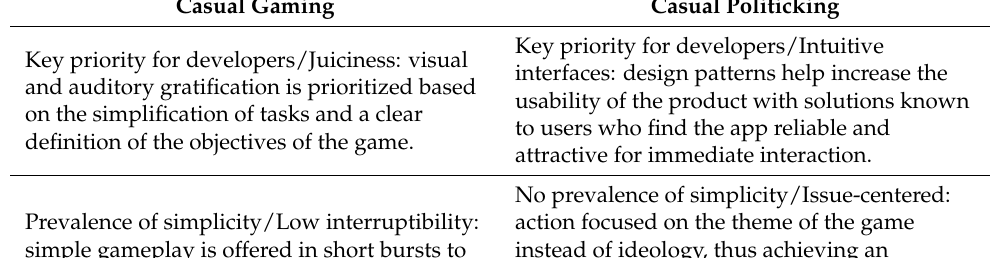
Table 1. Proposal for a comparison between the principles of participation in “casual games” and “casual politicking”.